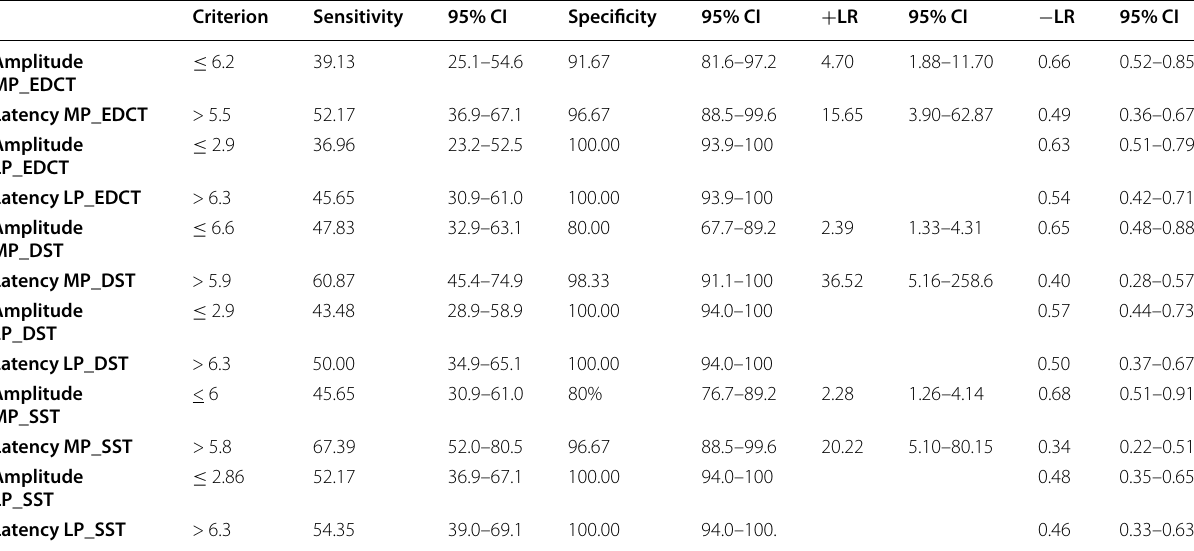
Table 3 Cut-off values, specificity, and sensitivity of the novel tests based on ROC curve analysis comparing cases with controls